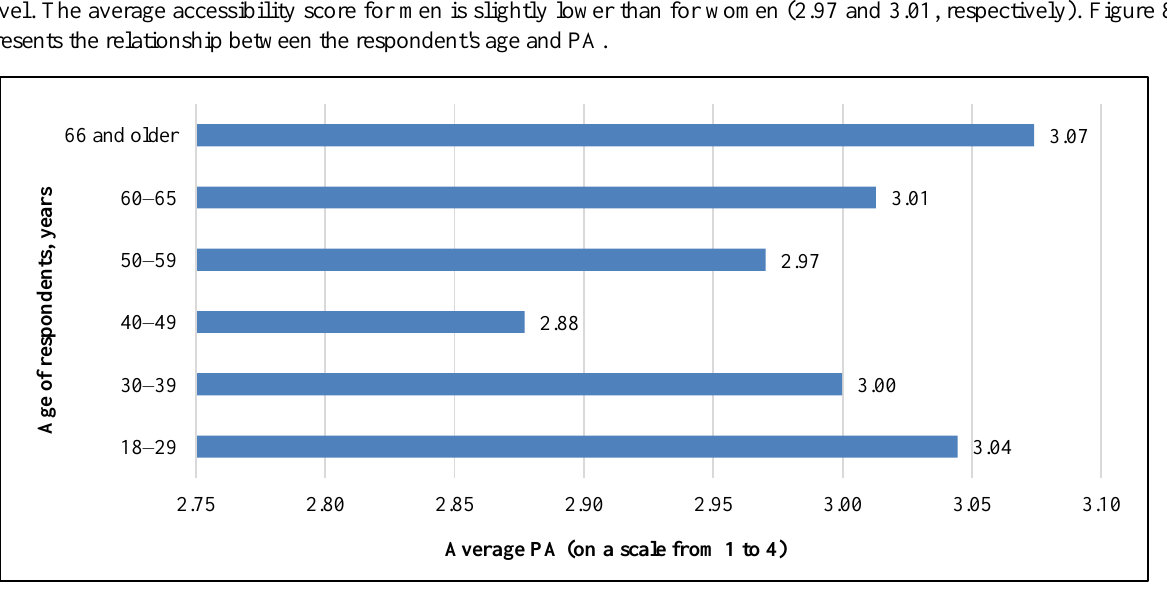
Figure 8. Relationship between respondent's age and